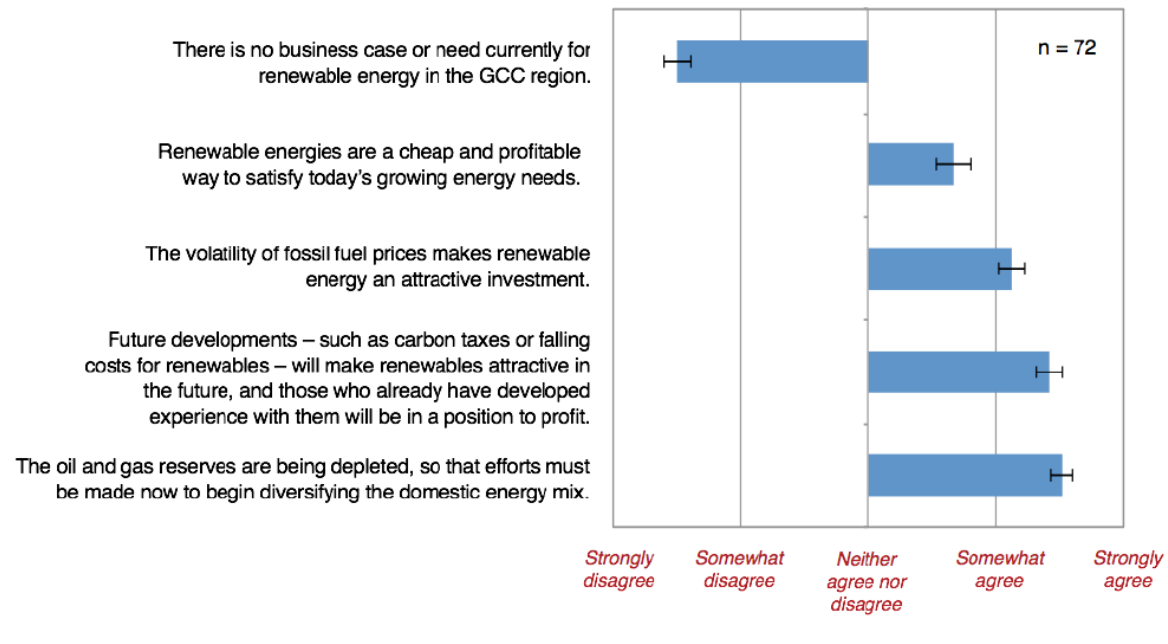
Figure 2. Results of question 1—the overall case and need for renewables in the GCC countries. The bars show the mean value and the error bars show a confidence interval of one standard